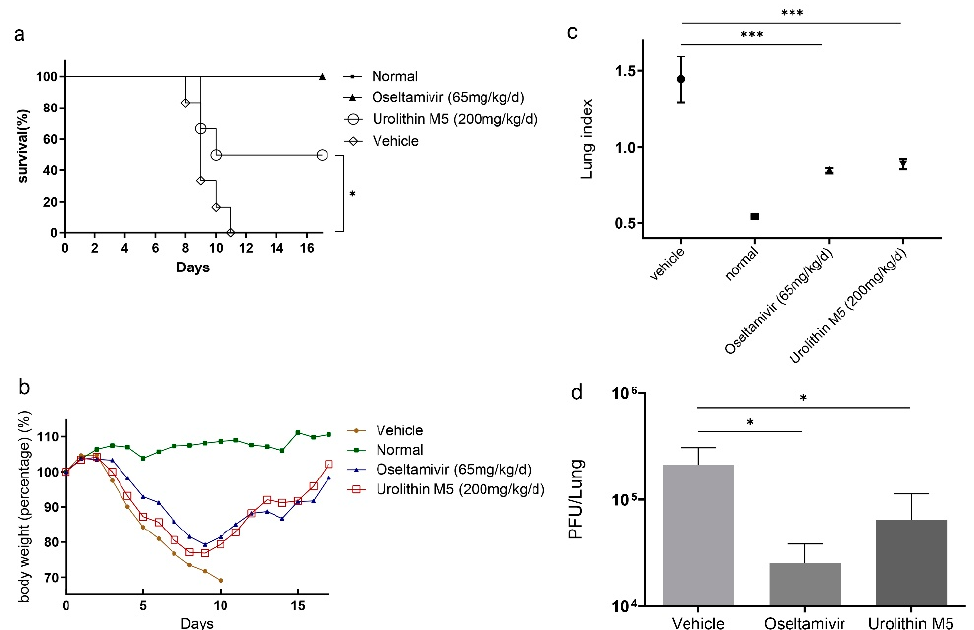
Figure 3. Urolithin M5 exhibited antiviral activities in PR8-infected mice. PR8-infected mice were administrated orally with 200 µ L of 200 mg/kg/d urolithin M5, 65 mg/kg/day oseltamivir or 0.5% CMC for 6 consecutive days. ( a ) Body weights and ( b ) survival rate are shown. The efficacy of urolithin M5 and oseltamivir treatment on ( c ) lung index and ( d ) lung viral load of mice are shown. Six mice of each group were measured, and each assay was performed three times for confirmation. (* p 0.05, *** p 0.001)